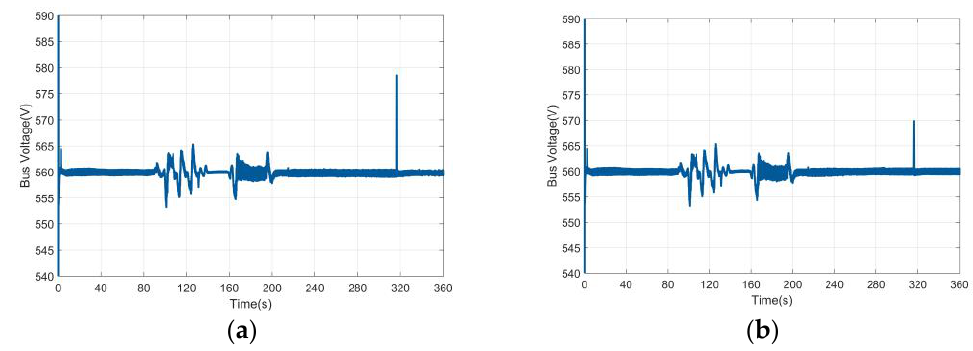
Figure 28. Bus voltage fluctuation graph for different strategies: ( a ) conventional vessel energy management strategy; ( b ) improved vessel energy management strategy.